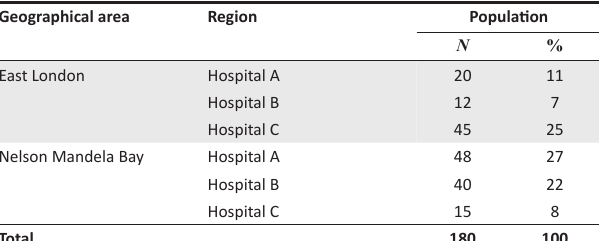
TABLE 1: Population of professional nurses in private intensive care units in Nelson Mandela Bay and Buffalo City. Geographical area Region